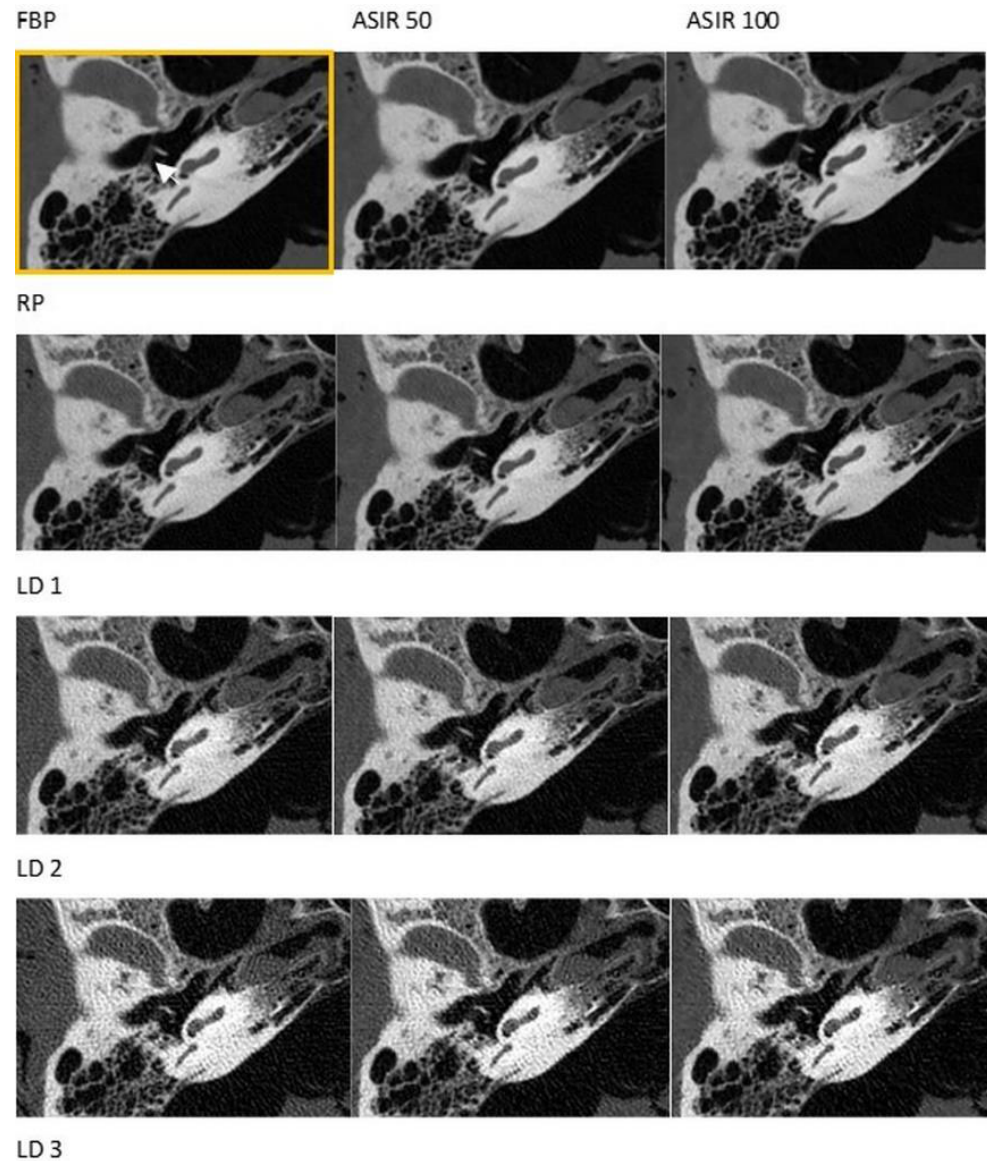
Figure 1. Visualization of the chorda tympani (white arrow). RP = reference protocol (83.72 mGy), LD1 = low dose 1 protocol (26.79 mGy), LD2 = low dose 2 protocol (7.66 mGy), LD3 = low dose 3 protocol (4.82 mGy). Yellow box = reference image using reference protocol and filtered back projection.